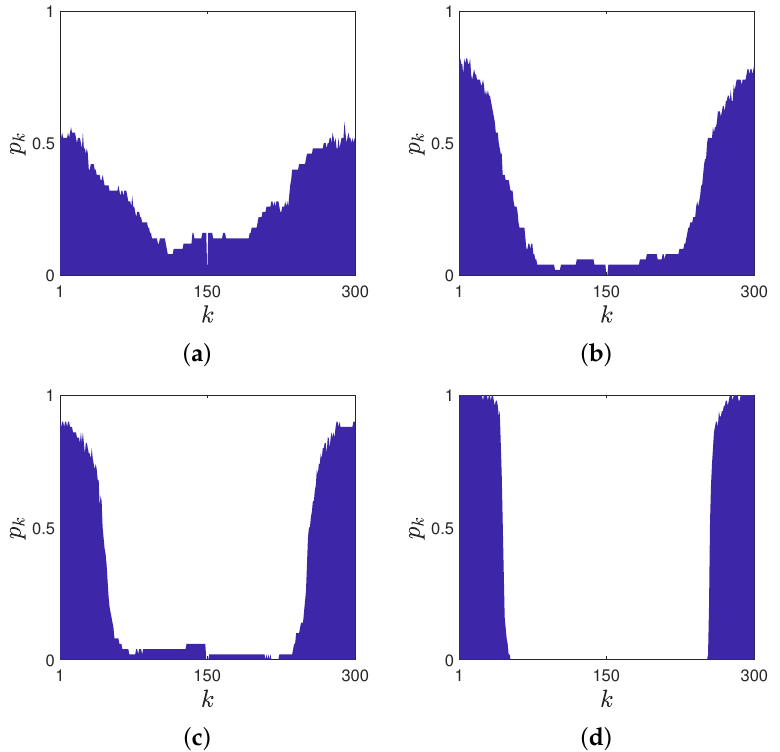
Figure 5. The number of pruned neurons affects the performance of the system. ( a ) Probability distribution of the position of coherent domain when N p = 1 (node 150), ( b ) N p = 2 (nodes 150 to 151), ( c ) N p = 3 (nodes 149 to 151), ( d ) N p = 5 (nodes 148 to 152). N = 300, other parameters are the same as in Figure